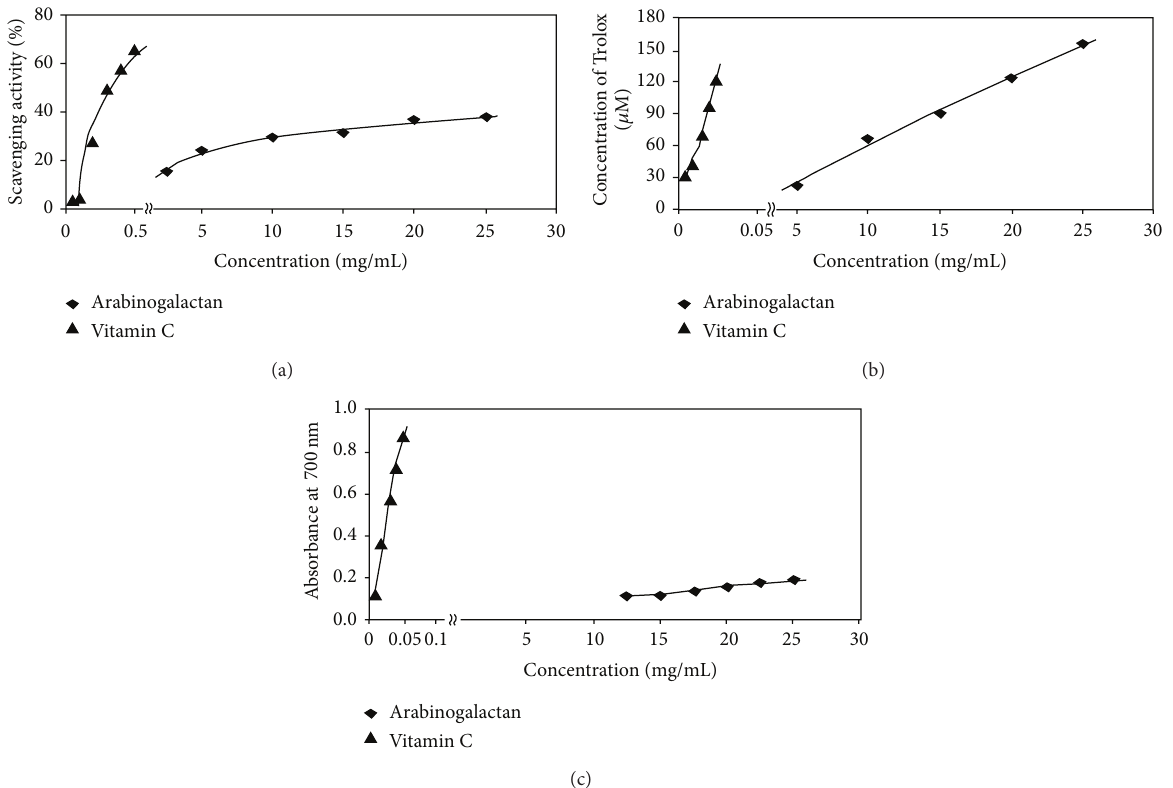
Figure 2: Antioxidant activities of larch arabinogalactan compared with vitamin C. (a) Hydroxyl radical-scavenging capacity. (b) Ferric- reducing antioxidant power. (c) Reducing power.